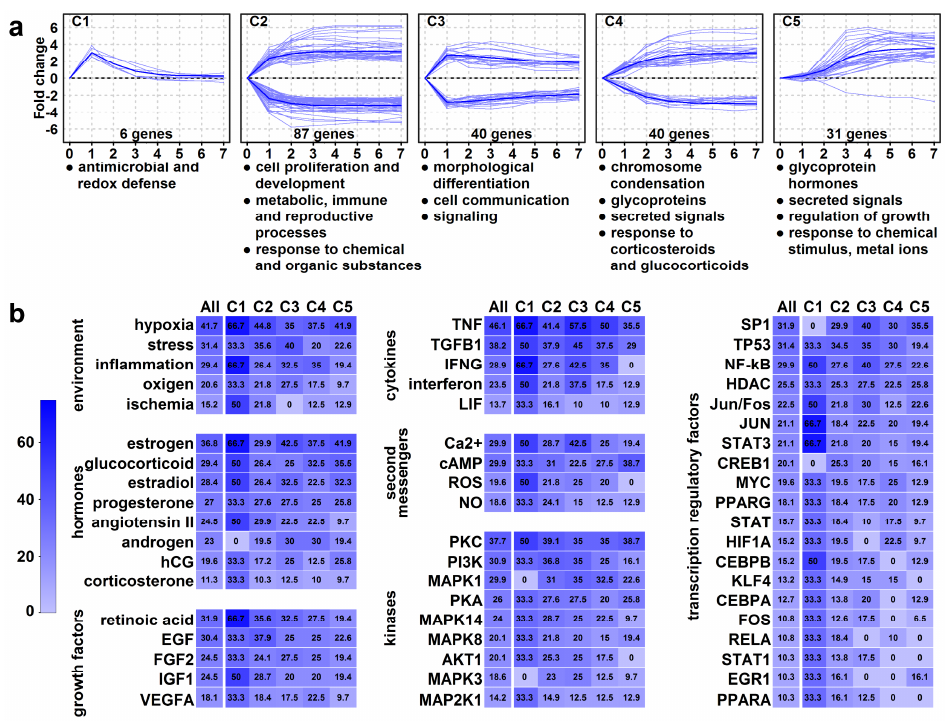
Figure 7. Genes with high expression change (HEC). ( a ) The graphs show the temporal expression pattern of genes in the clusters. Individual gene expression data (log 2 -fold change compared to day 0 is depicted with light blue lines, while mean cluster gene expression data is shown with dark blue lines. Cluster enrichments were assessed using DAVID, the significance threshold was set at FDR < 0.2. The biologically most relevant, terms were listed below the clusters. ( b ) The common regulators of clusters were analyzed using Pathway Studio 9.0, the significance threshold was set at p < 0.05. The percentage of HEC genes (“All”) or genes in clusters (C1–C5) regulated by various environmental stimuli or physiological regulators are depicted in heat maps. The color code depicts percentages.